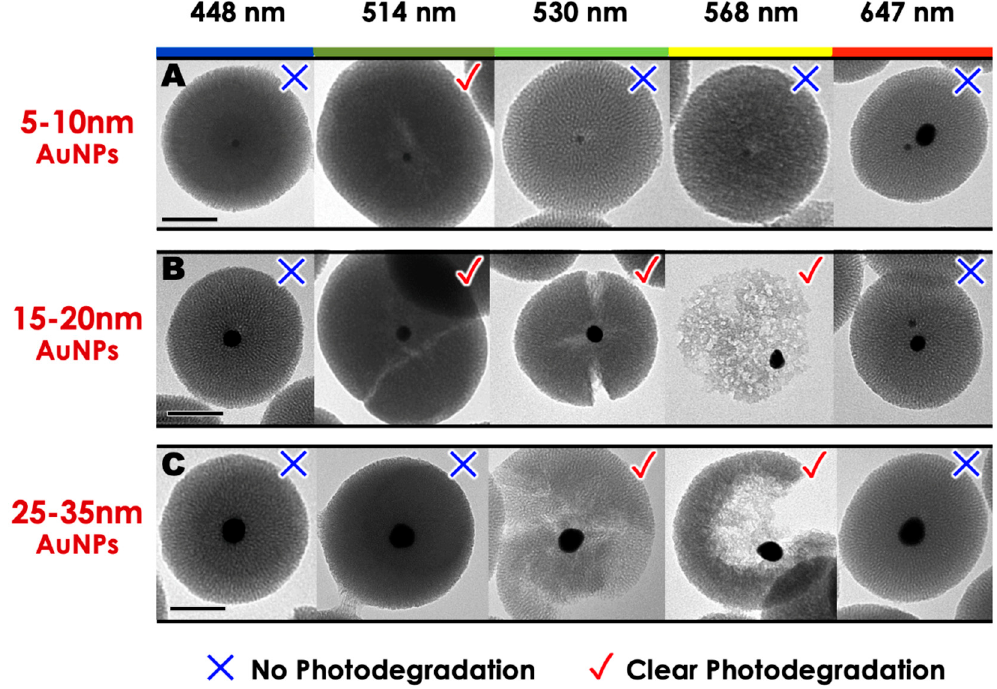
Figure 4. TEM images of three ranges of gold nanoparticle (NP) sizes in the mesoporous silica shells: 5–10 ( A ), 15–20 ( B ), and 25–35 nm ( C ) irradiated at five different wavelengths (448, 514, 530, 568, 647 nm) under 20 mW for 30 min. Representative most damaged NPs are presented for each size and wavelength. Scale bars of 50 nm are shown.